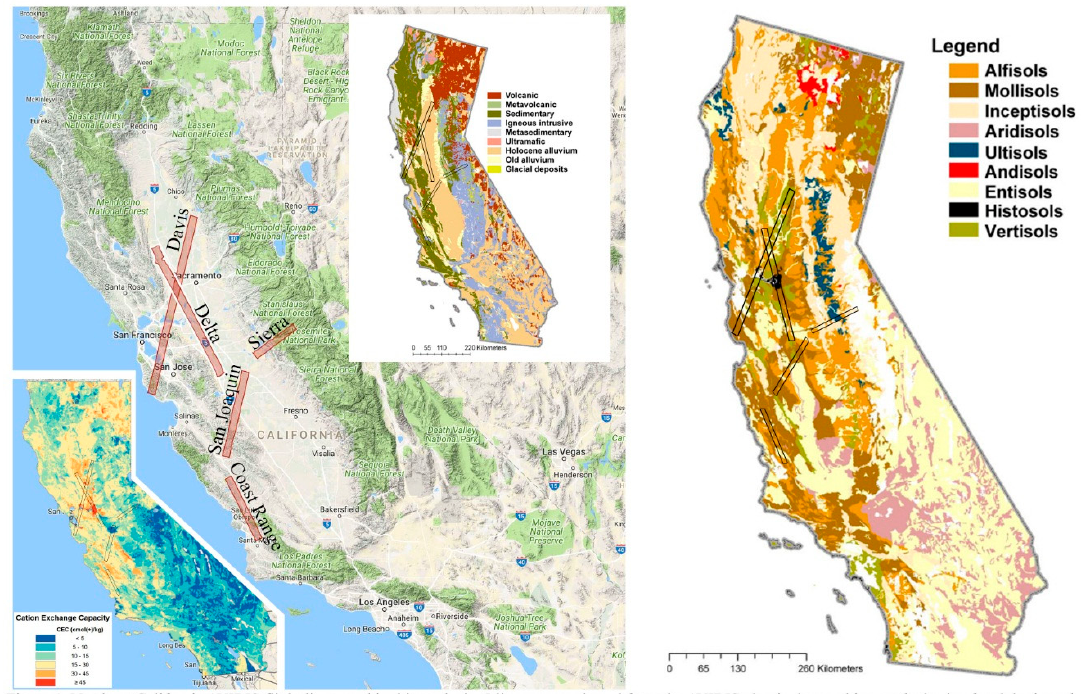
Figure 1. Northern California AVIRIS flight lines used in this analysis. Five lines were selected from the AVIRIS classic data archive on the basis of pedologic and agricultural diversity. Landsat 8 acquisitions were collected on the same day as each of the five flight lines. Simplified maps showing soil orders (right), as well as lithologic provenance (inset, upper right), and cation exchange capacity (inset, lower left) illustrates the complexity of soil properties in the study area. Six of the nine soil orders are represented in these flight lines. Soil maps from the UC Davis California Soil Resource Lab (https://casoilresource.lawr.ucdavis.edu/). Map data © 2017 Google INEGI.